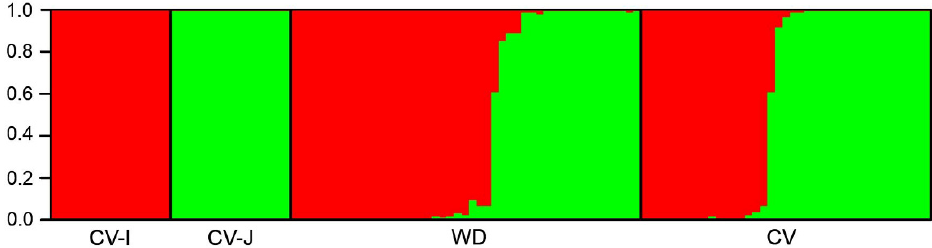
Figure 8. The genetic structure of standard indica (CV-I) and japonica (CV-J) varieties, weedy rice (WD), and cultivated rice (CV) samples based on the InDel (insertion/deletion) molecular fingerprints. When the K value was 2, CV-I (red) and CV-J (green) varieties showed two distinct genetic components. Accordingly, both WD and CV samples also showed the two distinct genetic components (red and green). Each sample is represented by a single vertical line (bar) assigned into the two-colored segments (genetic components), with lengths proportional to each of the two inferred clusters. Numbers at the vertical axis represent the probability of assignment.